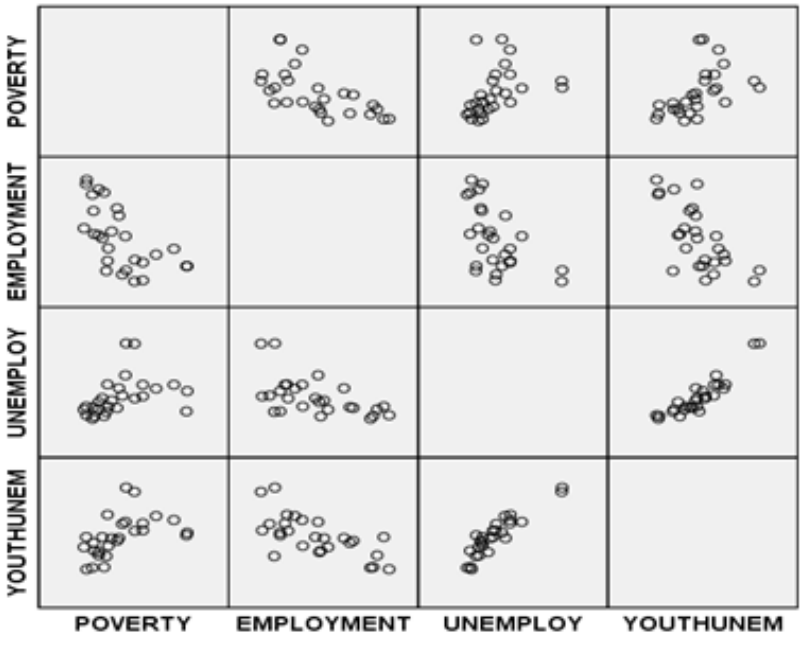
In Figure 3 the swallow-tail plot matrix for the four indicators mentioned in sec- tion 2 is presented. The sign (positive or negative) and the magnitude of the correlation for each pair of variables may be detected at a glance by means of the orientation of the two axes and this is an advantage with respect to the classical scatterplot matrix (Figure 4). Furthermore the shape of the left tail and right tail in each panel of the swallow-tail matrix points out the potential univariate or bivariate